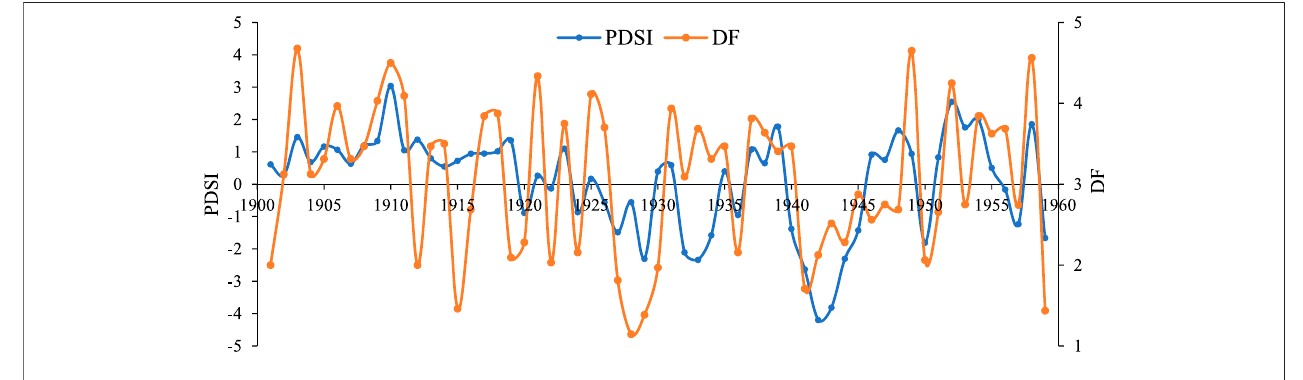
FIGURE 7 | Comparison of PDSI and drought/ fl ood grade